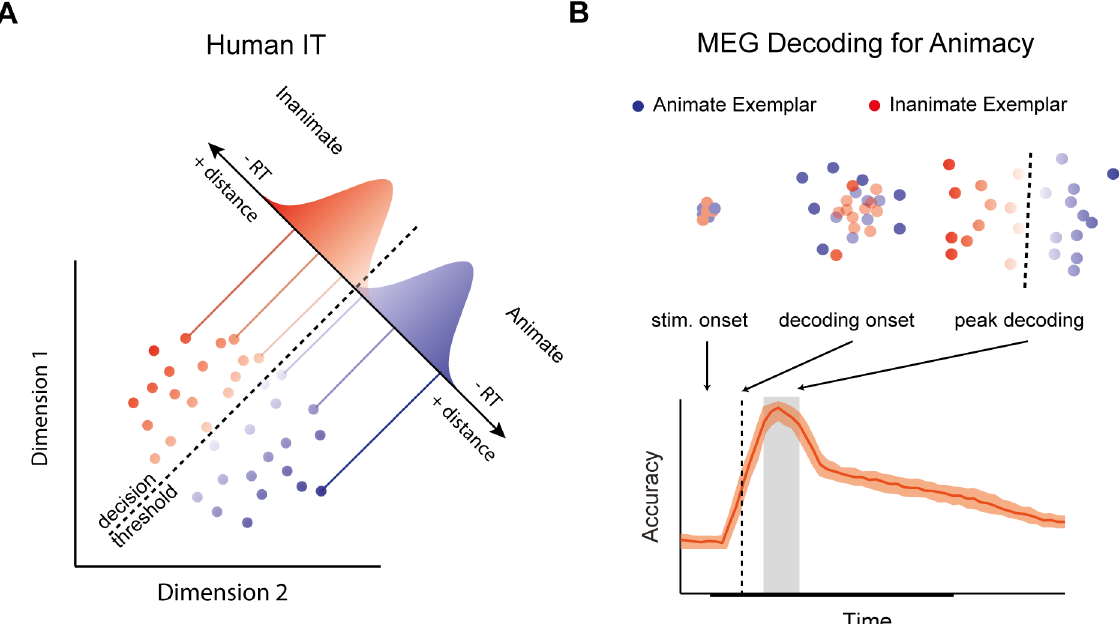
Fig 1. Distances from a decision boundary through activation space can be used to predict reaction times (RT). (A) A hypothetical 2D activation space for human IT representing animate and inanimate object exemplars. Activation patterns for individual exemplars are projected onto a discriminant axis, which differentiates patterns based on animacy. A decision boundary placed along the axis allows for classification of animate and inanimate exemplars. Gaussian distributions along the discriminant axis reflect “ decision noise ” . Exemplar representations closer to the boundary produce more ambiguous evidence compared to exemplar representations far from the boundary. An implication of classic signal detection theory is that RTs will correlate negatively with distance from the boundary. (B) A hypothetical emergent activation space for animate vs. inanimate object exemplars as would be revealed using MEG decoding methods. Stimulus onset is the time the stimulus is presented. The decoding onset (dashed line) is the first time point that a classifier trained to discriminate between animate and inanimate examplars performs significantly above chance. Peak decoding (gray box) is the optimal time point to read out information about stimulus category. Clusters depict the hypothetical 2D activation spaces at notable points in the decoding time-course.